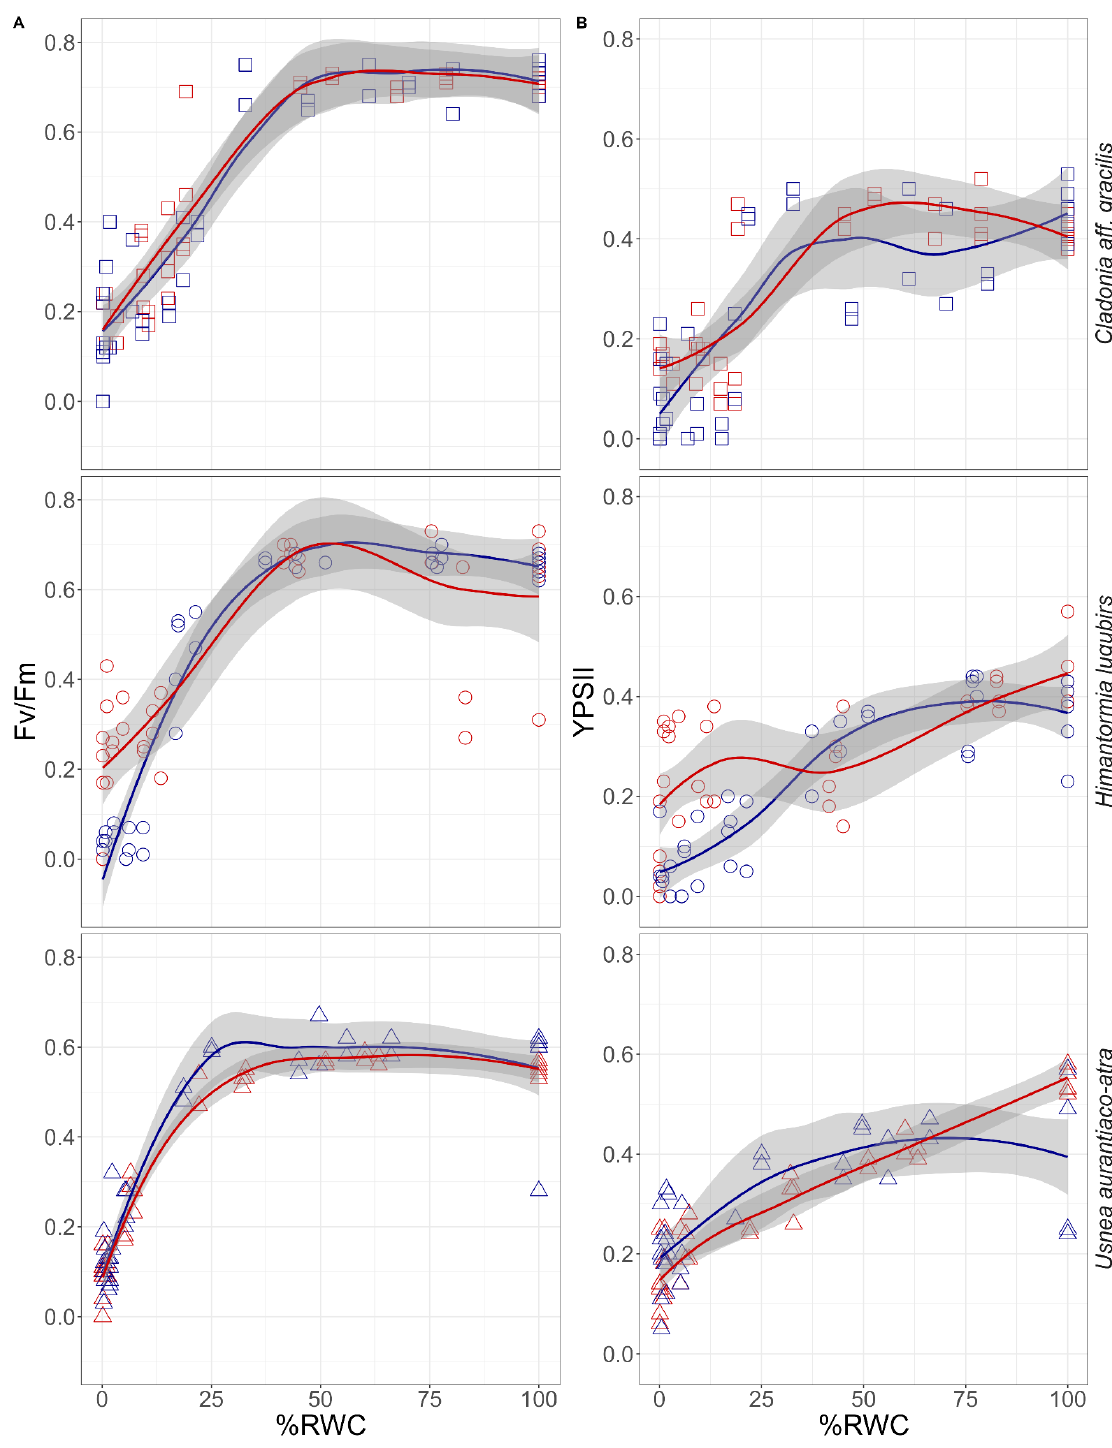
dry state (RWC = 0%). Tendency lines correspond to local polynomial regression fitting, and gray area indicates the standard error of the tendency lines using t-based approximation; n = 6 for each hour and species measured.